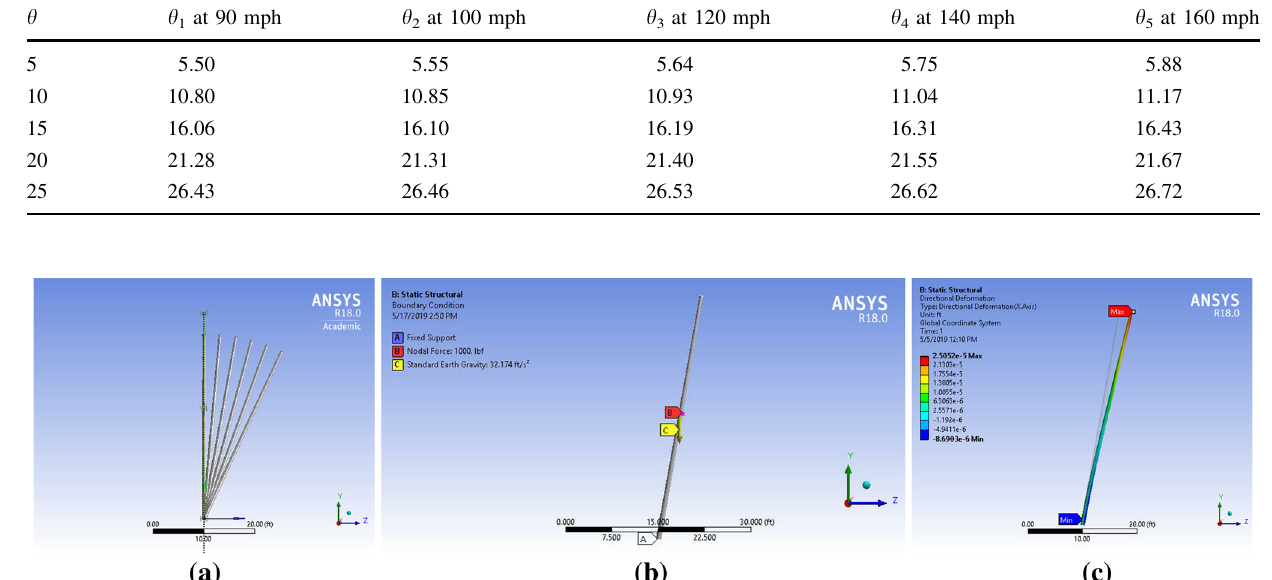
Fig. 4 Angular deflection of utility poles under stress: a the positions of a pole at 0 (cid:4) , 5 (cid:4) , 10 (cid:4) , 15 (cid:4) , 20 (cid:4) , and 25 (cid:4) ; b the boundary conditions used in ANSYS (cid:3) Workbench; and c the directional deflection of a pole